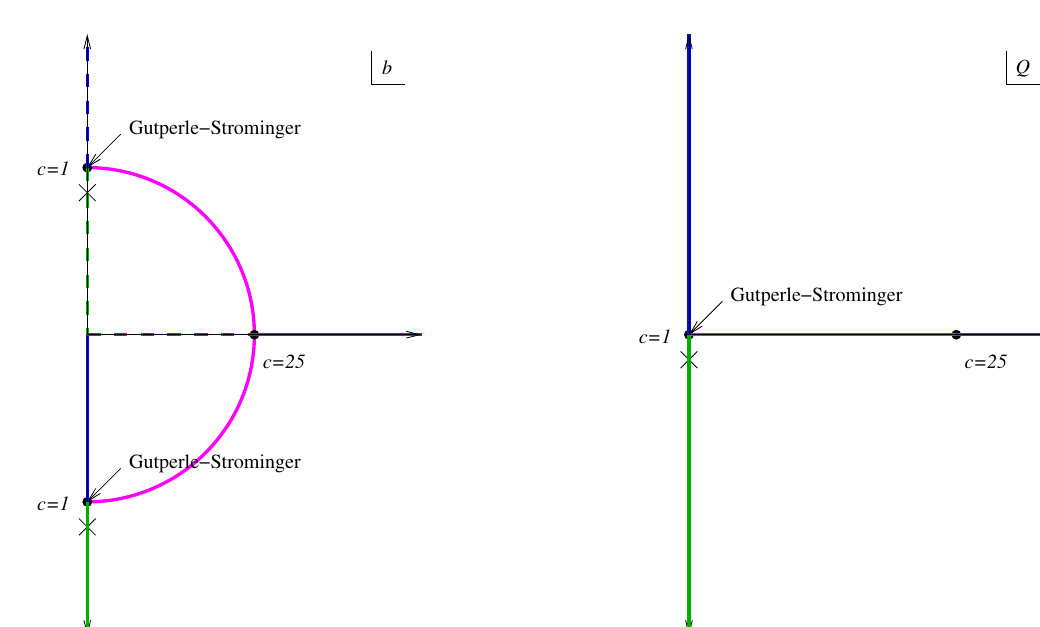
Figure 6. Plane of complex parameters b and Q . These two planes are related by two to one map. The two sheets of Q plane embedded in the b plane correspond to the degeneracy of the b ↔ 1 /b exchange. On the b plane, it maps the interior of the pink semi-circle to the exterior. The × indicate the point where ¯ b > 1 and its ¯ b ↔ − 1 / ¯ b